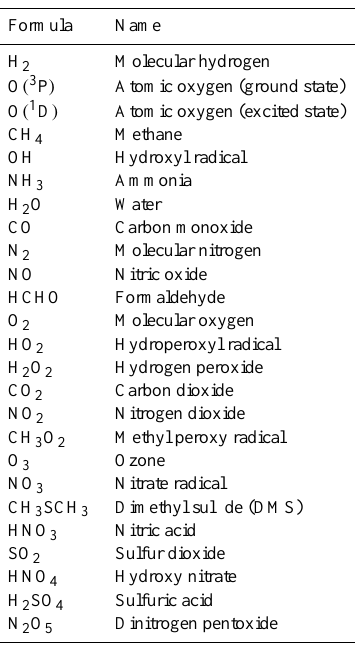
Table. B1. Gas phase chemical species used in this work.